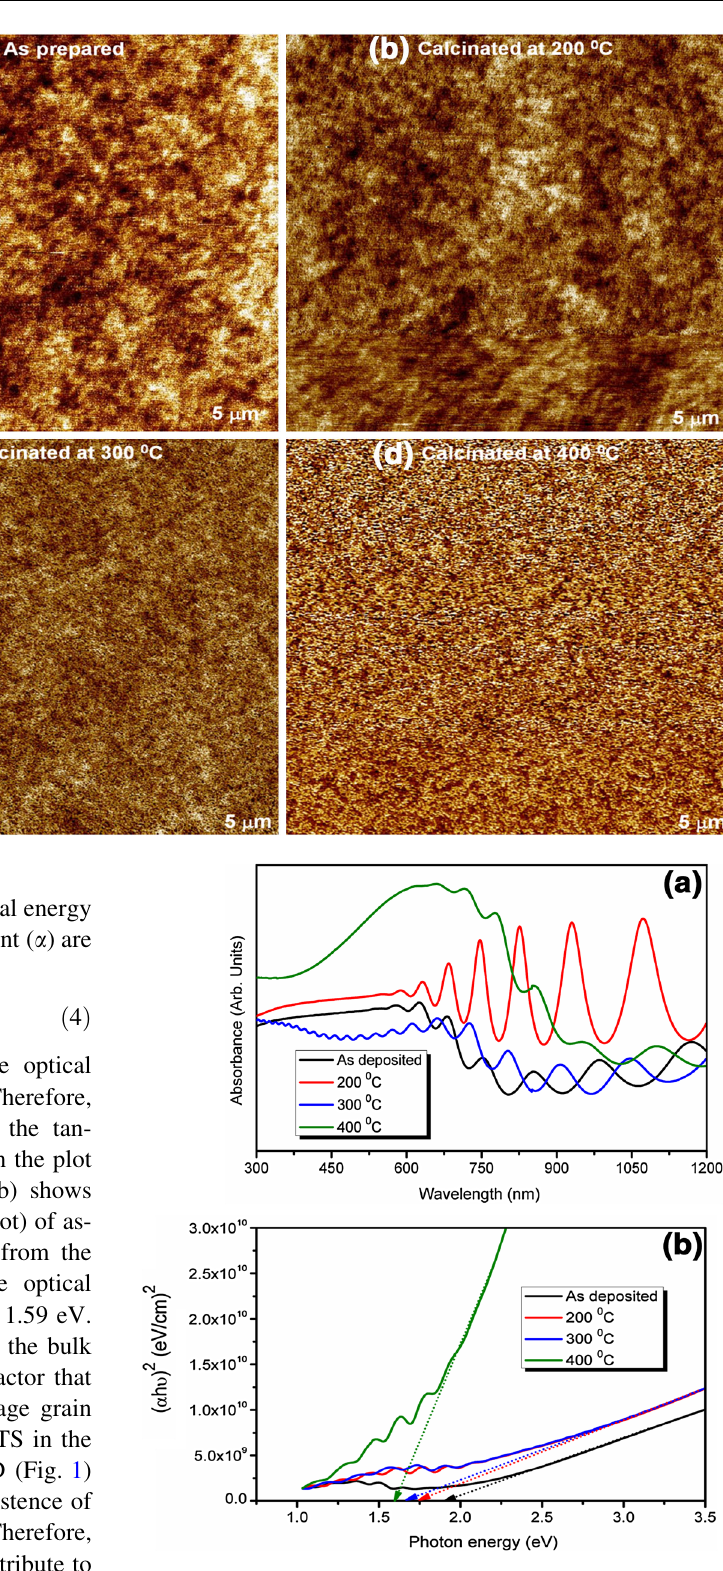
Fig. 6 a UV–Visible NIR spectra recorded showing absorbance versus wavelength plot for CZTS thin films. b Plot of ( a h t ) 2 versus photon energy (h t ) to determine optical bandgap for as-deposited and calcinated CZTS